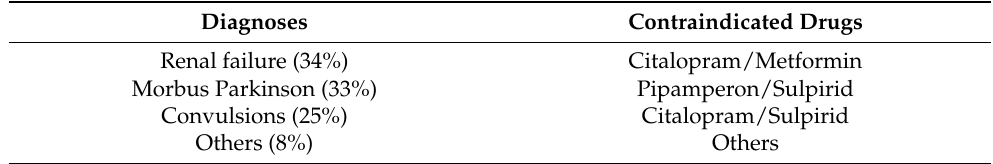
Table 4. Diagnosis-related MRP